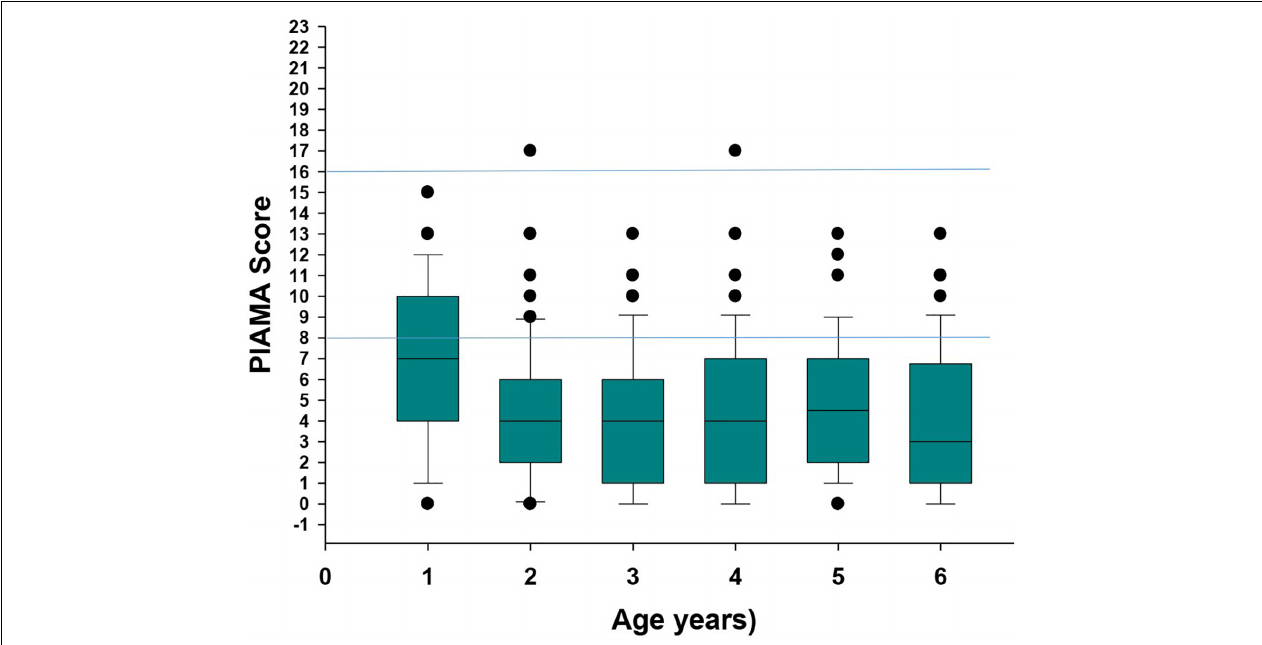
FIGURE 2 | PIAMA* score in children with CF. Box and whisker indicating the median (horizontal line) and the upper and lower quartiles of the PIAMA* score. The black dots indicate the outliers. The blue horizontal lines indicate the risk of asthma in non-CF patients between 6 and 8 years of age according to the PIAMA* score: